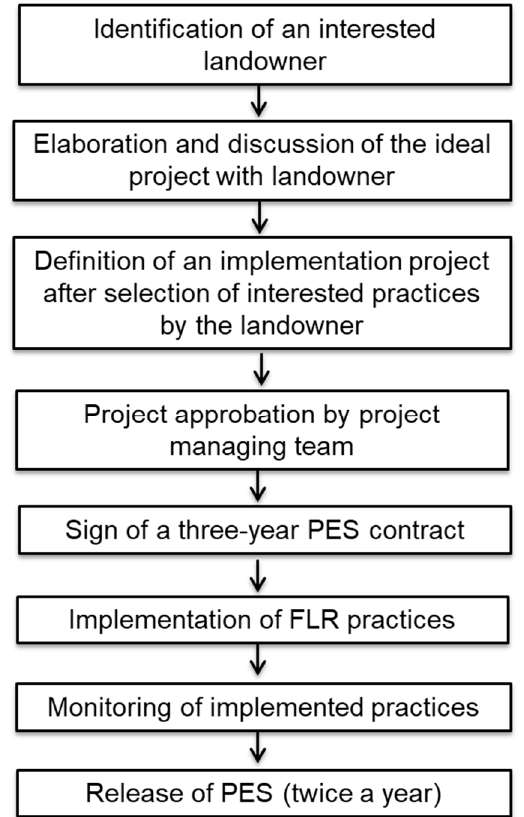
Figure 4. Sequence of actions for the implementation of forest and landscape restoration practices in the Water Producer project, Piracicaba, Capivari, and Jundiai Watershed, Atlantic Forest, Brazil. Modified from [24] (p. 41).